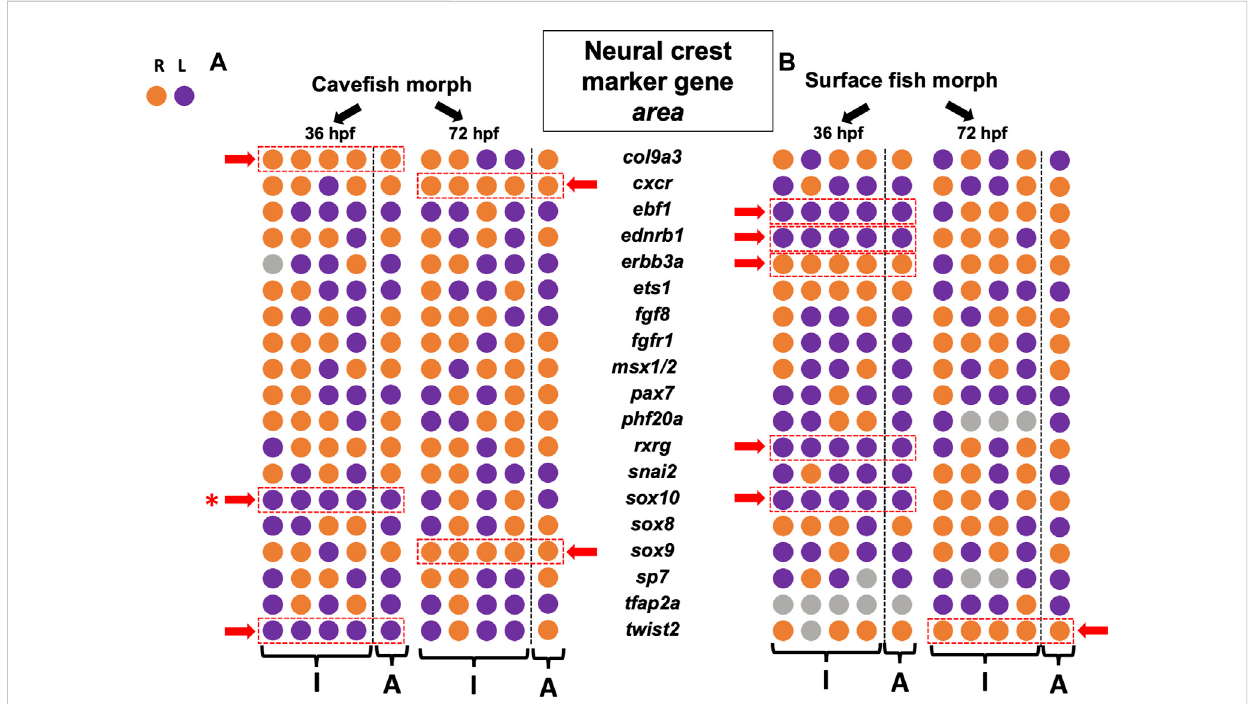
FIGURE 2 Asymmetry measures for gene expression area across the left-right axis reveals more lateralization at early stages in both cave and surface morphs. Each of 19 gene markers involved in diverse stages of neural crest development are arrayed for two morphotypes [cave at (A) , surface at (B) ] across two stages of development (36 hpf and 72 hpf). The fi rst four circles in each row represent the individual polarities ( “ I ” ) for lateralization in quanti fi ed expression area (right = orange, left = purple). The fi nal circle is the polarity for the aggregate mean value across n = 4 specimens ( “ A ” ). Those genes demonstratingconsistency inasymmetric polarity acrossall four individuals andtheaggregate areindicated (dashed redrectangle, red arrow).Both cave and surface fi sh showed fewer examples of consistent asymmetry at 72 hpf compared to 36 hpf. Overall polarities were mixed, with no obvious bias towards the right or left for any gene, with the exception of sox10 (red asterisk, see Figure